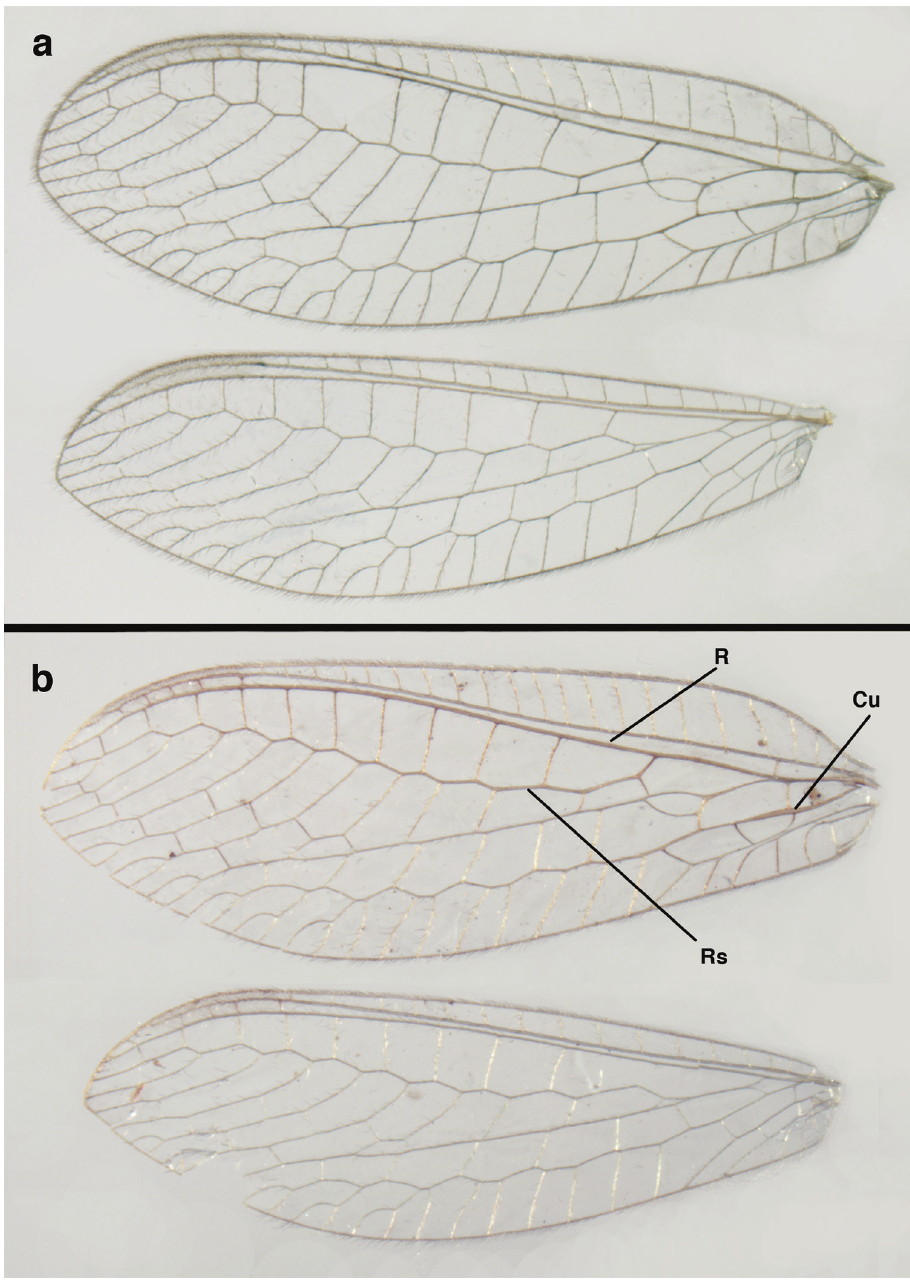
Figure 131. Ungla elbergi Tauber, sp. n. Wings, ( a ) female ( b ) male. Cu Cubitus R Radius Rs Radial sector (Argentina; a La Rioja, paratype, female, EMEC; b Tucumán, holotype, male,